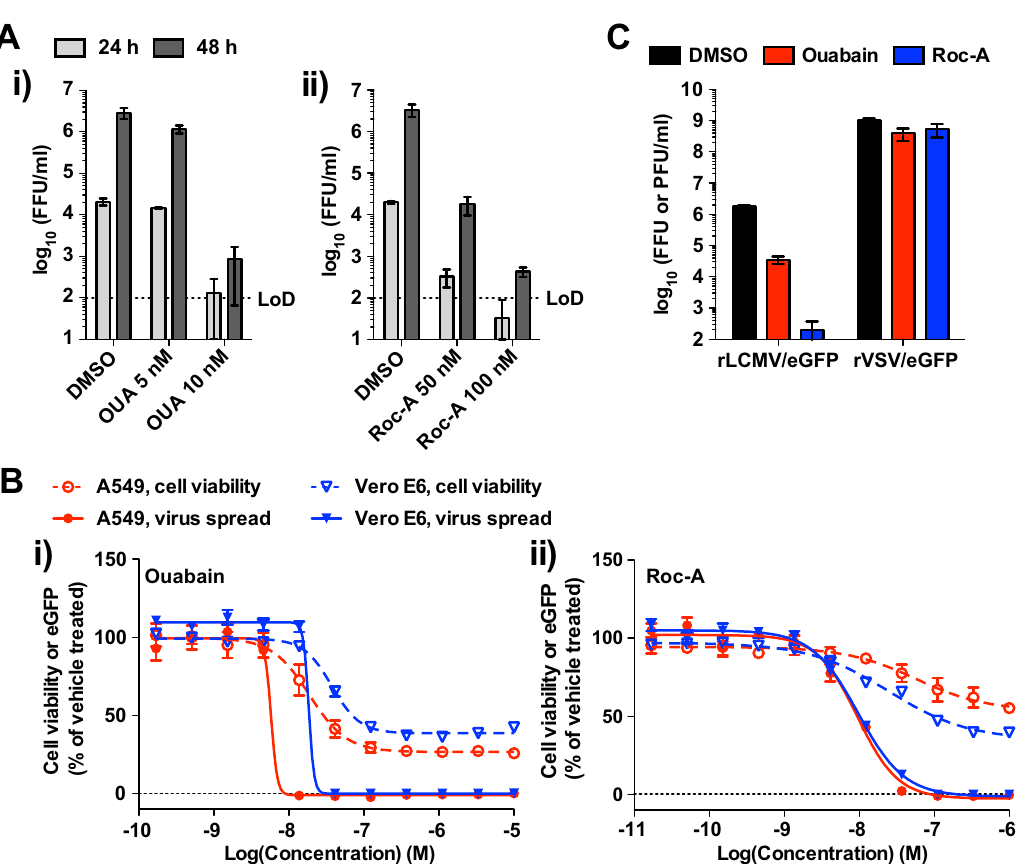
Fig 5. Effect of pharmacological inhibition of ATP1A1 and PHB on LCMV multiplication. (A) A549 cells seeded (1.25 x 10 5 cells/well) in 24-well plates and cultured overnight were treated with either ouabain (OUA) (i) or rocaglamide (Roc-A) (ii) at indicated concentrations or with DMSO (vehicle control) for 2 h and then infected (MOI = 0.01) with rLCMV/eGFP. Compounds were present throughout the experiment. At 24 and 48 h pi, TCSs were collected, and virus titers determined by IFFA. Data represent means ± SD of results from three independent experiments. LoD, the limit of detection. (B) Inhibitory effects of ouabain and Roc-A on virus propagation and cell viability. A549 cells seeded (2.0 x 10 4 cells/well) in 96-well plates and cultured overnight were treated with 3-fold serial dilutions of either ouabain (i) or Roc-A (ii) for 2 h and then infected (MOI = 0.01) with rLCMV/eGFP. Compounds were present throughout the experiment. At 48 h pi, cells were fixed to examine eGFP expression and cell viability as determined by CellTiter 96 AQ ueous one solution reagent. The data represent means ± SD of the results from four (cell viability assay) or six (virus spread assay) replicates. The therapeutic index (TI) was calculated by dividing CC 50 by IC 50 . (C) Effect of ouabain or Roc-A treatment on rVSV/eGFP multiplication. A549 cells seeded (1.25 x 10 5 cells/well) and cultured overnight were treated with either ouabain (10 nM) Roc-A (100 nM), or vehicle control (DMSO) for 2 h and infected (MOI = 0.01) with either rLCMV/eGFP or rVSV/eGFP. At 72 h pi, TCS was collected, and virus titers were determined by IFFA (rLCMV/eGFP, expressed as FFUs) or a plaque assay (rVSV/eGFP, expressed as PFUs). Compounds were present to study endpoint. Results represent means ± SD of the results of three independent